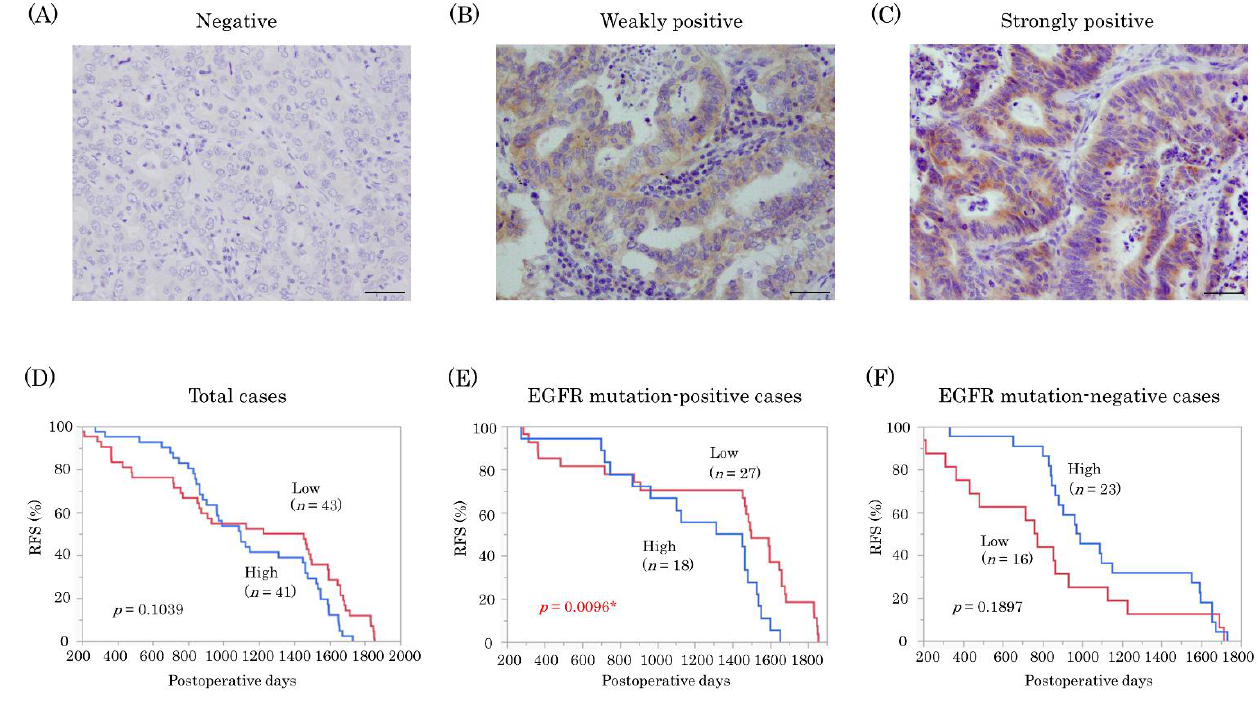
Figure 5. Immunohistochemistry of EphB4 in patients with lung adenocarcinoma. ( A – C ) Representative illustrations of immunohistochemistry of EphB4 in patients with lung adenocarcinoma (bar: 50 μm). EphB4 immunoreactivity was detected in both the cytoplasm and membrane of tumor cells: ( A ) negative, ( B ) weakly stained, and ( C ) markedly stained. ( D – F ) RFS in patients with high and low EphB4 expression. ( D ) RFS in all 84 cases. ( E ) RFS in 45 EGFR mutation-positive cases. ( F ) RFS in 39 EGFR mutation-negative cases. The high expression of EphB4 was a significant poor prognostic factor in EGFR mutation-positive cases. * p < 0.05.